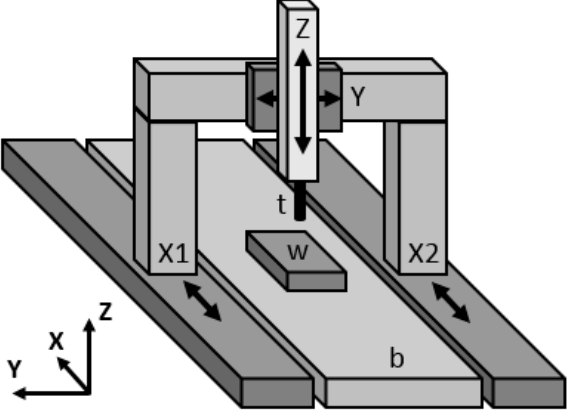
Figure 2. Schematic representation of the kinematic chain of the virtual machine tool.